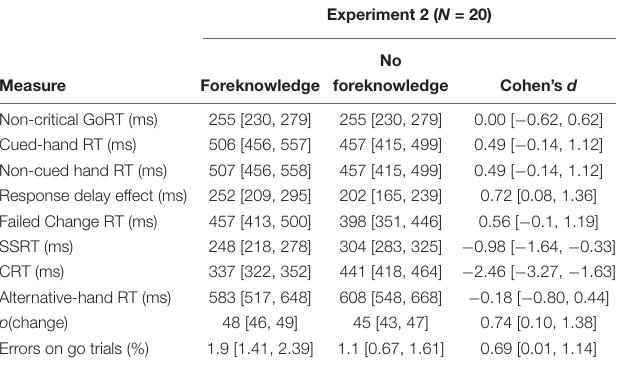
TABLE 3 | Means and confidence intervals for Experiment 2 (N =